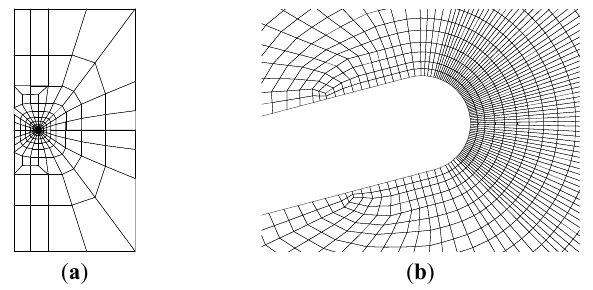
Figure 2. Finite element mesh: ( a ) general view and ( b ) kinked crack tip.